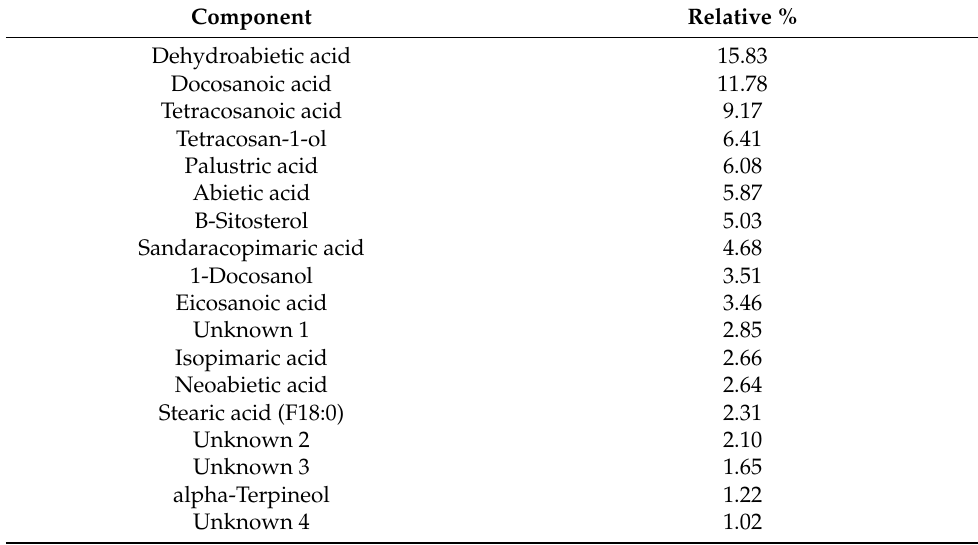
Table 2. Chemical composition of principal components detected in the